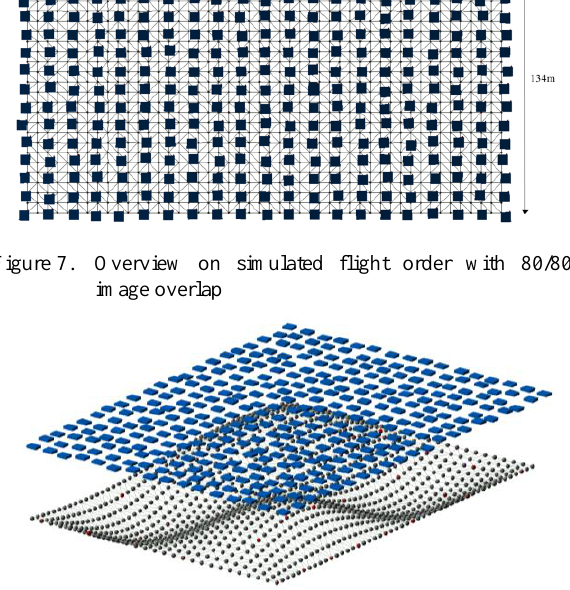
Figure 8. Simulated UAV flight scenario above area